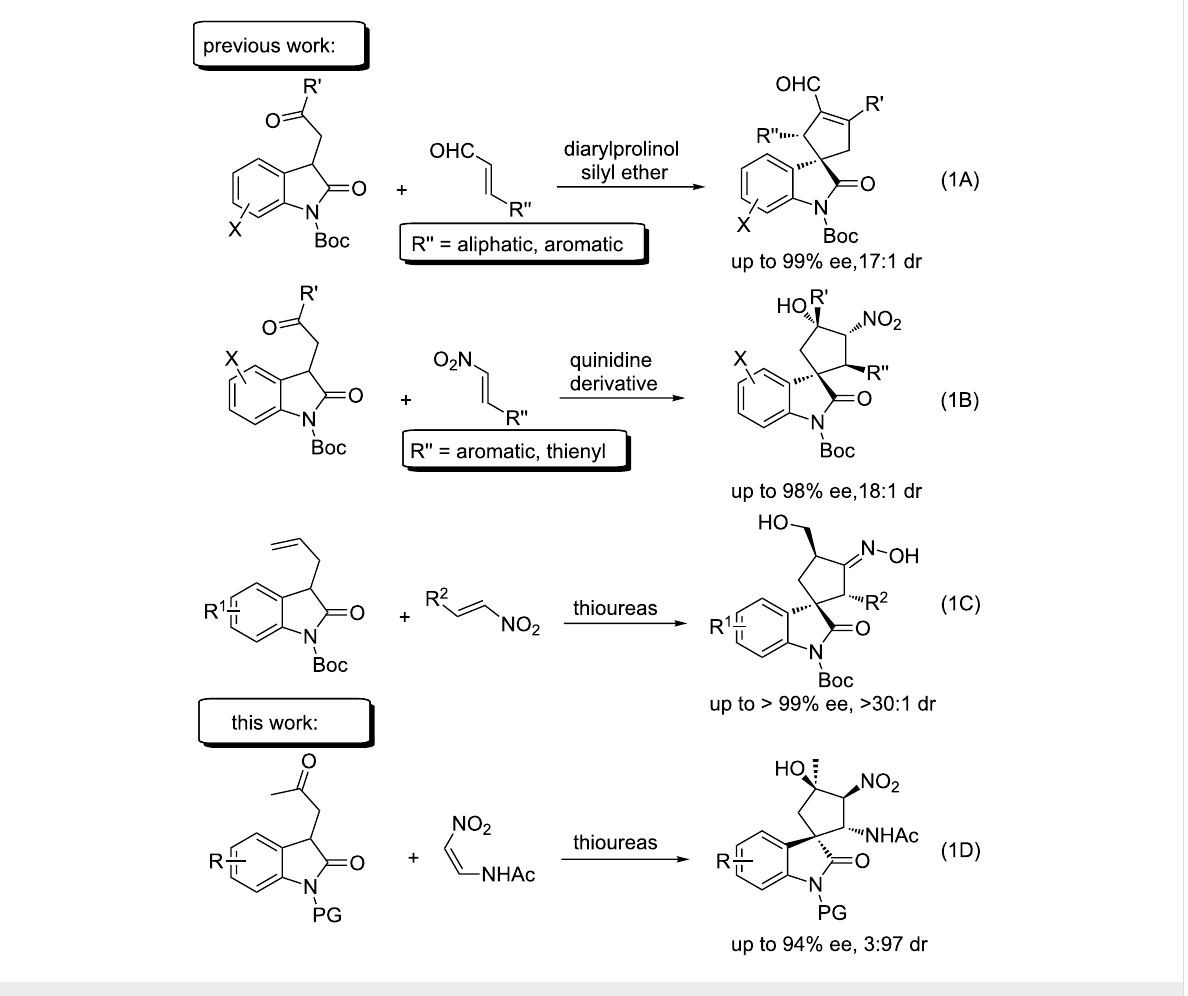
Scheme 1: Construction of spirocyclopentaneoxindole